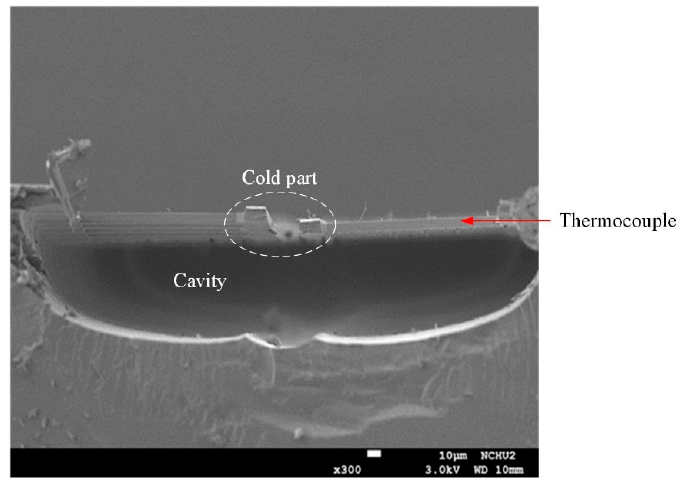
Micromachines 2022 , 13 , x FOR PEER REVIEW Figure 12. Cross-sectional image of the TEMH taken by SEM. Figure 12. Cross-sectional image of the TEMH taken by SEM.